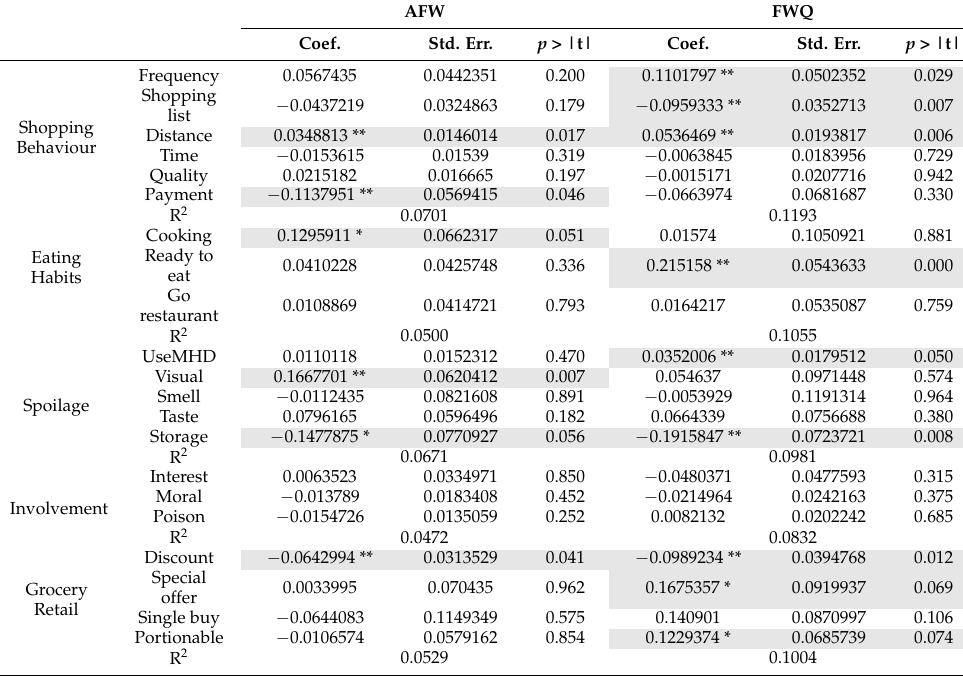
Table 9. Regression results.